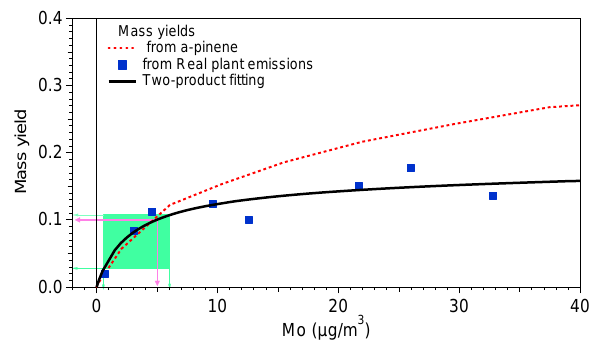
Fig. 4. The SOA mass yield curve from real plant emissions compared to α -pinene experiment. The blue rectangles are for SOA yields from each real plant emissions. The red dotted line is from the α -pinene SOA mass yields. Black solid curve is fitted to the real plant SOA yields by a two-product absorptive partitioning model with parameters of 0.1462, 0.3850, 0.0531 and 0.0160 for α 1 , K om,1 , α 2 , and K om,2 , respectively. The dark green bar shows the organic mass loadings in the aerosol phase observed in a boreal forest area, Hyytiälä (Raatikainen et al., 2010; Tunved et al., 2006a). The pink arrow points to an estimation of average global biogenic SOA mass concentration (5±3 µg m -3 ), corresponding to a SOA mass yield of 10±2%.